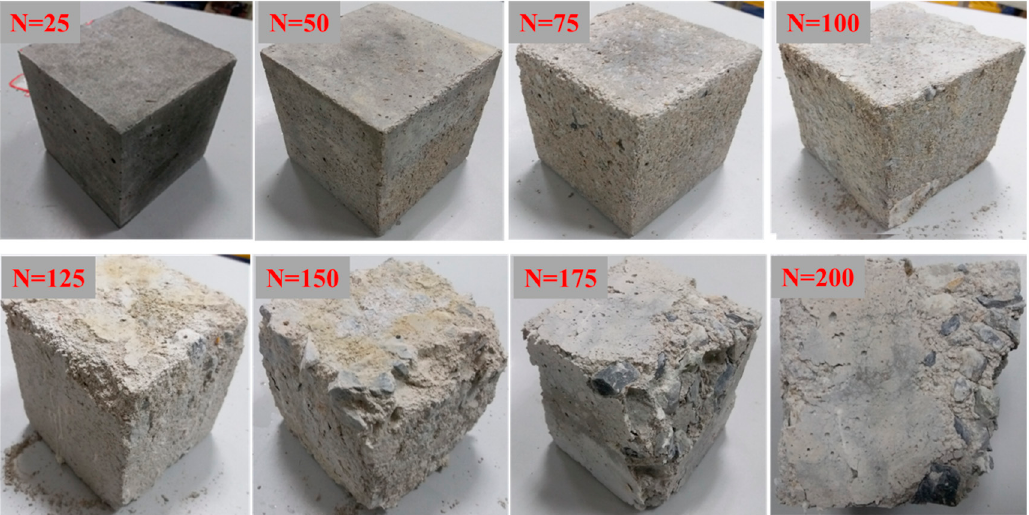
Figure 8. Typical failure characteristics of concrete cubic samples under different freeze–thaw cycles.